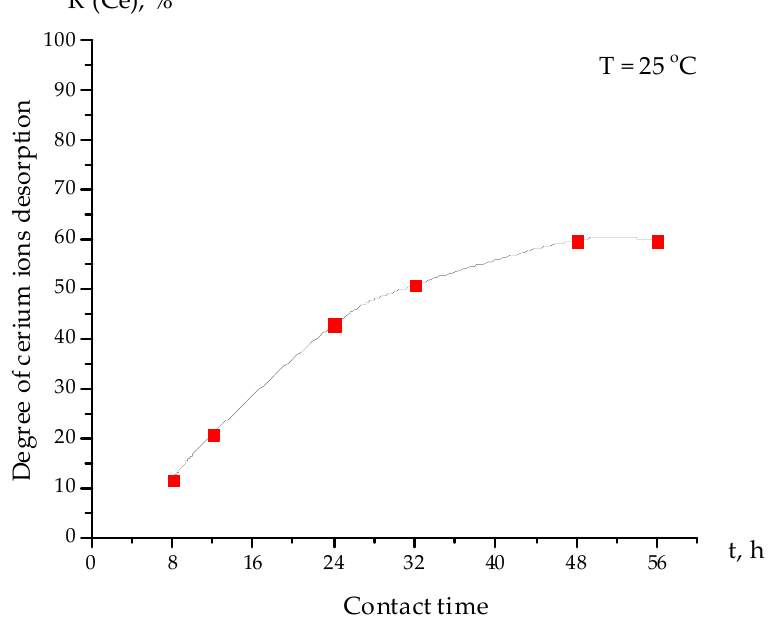
Figure 5. Kinetics of cerium ion desorption from the interpolymer system “Amberlite IR120H:AV-17-8” (4:2).